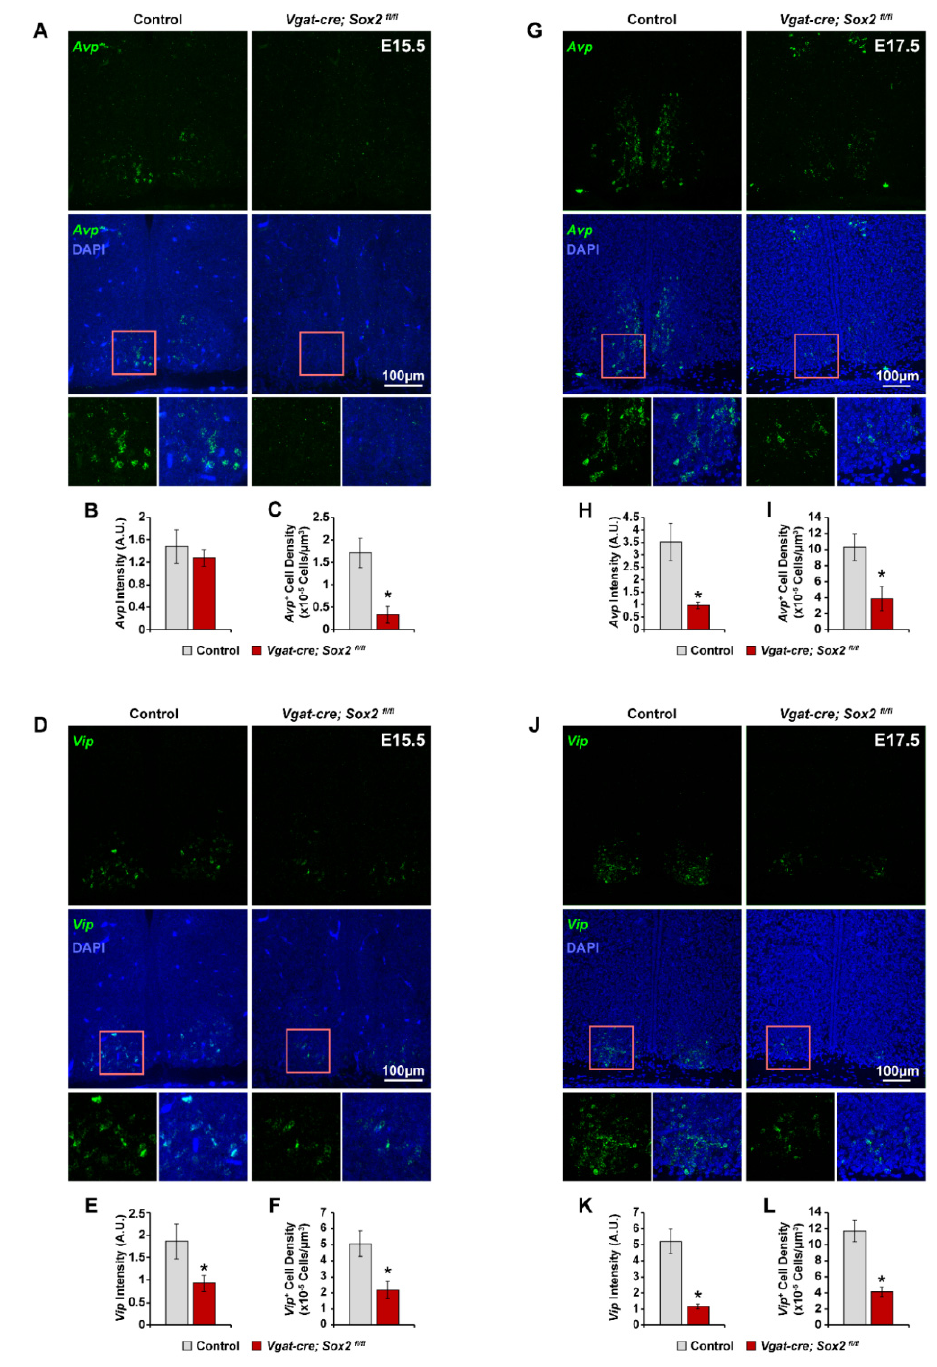
Figure 5. SCN-specific Sox2 ablation suppresses Avp and Vip expression at E15.5 and E17.5. ( A , G ) Representative photomicrographs of Avp expression (green) in the SCN of ( A ) E15.5 and ( G ) E17.5 control and Vgat-cre;Sox2 fl/fl mutant mice. Blue denotes DAPI. ( B , H ) Quantification of Avp expression in arbitrary units of mean grayscale intensity in the whole SCN at ( B ) E15.5 and ( H ) E17.5. ( C , I ) Quantification of Avp + cell density in the ( C ) E15.5 and ( I ) E17.5 SCN. ( D , J ) Representative photomicrographs of Vip expression (green) in the SCN of ( D ) E15.5 and ( J ) E17.5 control and Vgat-cre;Sox2 fl/fl mutant mice. Blue denotes DAPI. ( E, K ) Quantification of Vip expression in arbitrary units of mean grayscale intensity in the whole SCN at ( E ) E15.5 and ( K ) E17.5. ( F , L ) Quantification of Vip + cell density in the ( F ) E15.5 and ( L ) E17.5 SCN. Values represent mean ± SEM. * p < 0.05 versus control mice, two-tailed Student’s t -test. See Table 2 for the number of animals and litters